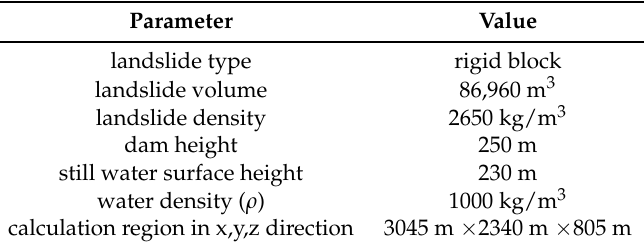
Table 6. Parameters in the Laxiwa model.